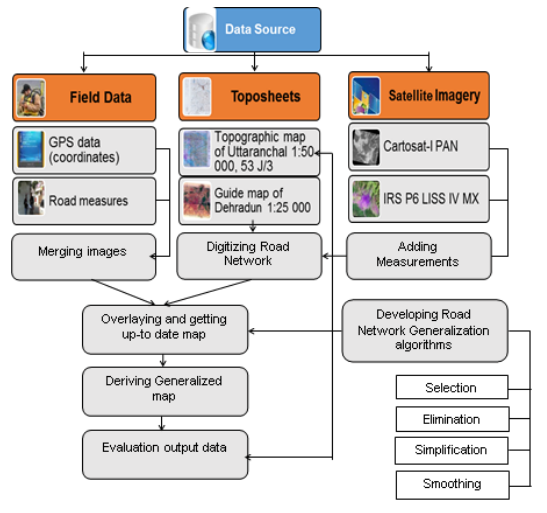
Figure 3: Flowchart of the research